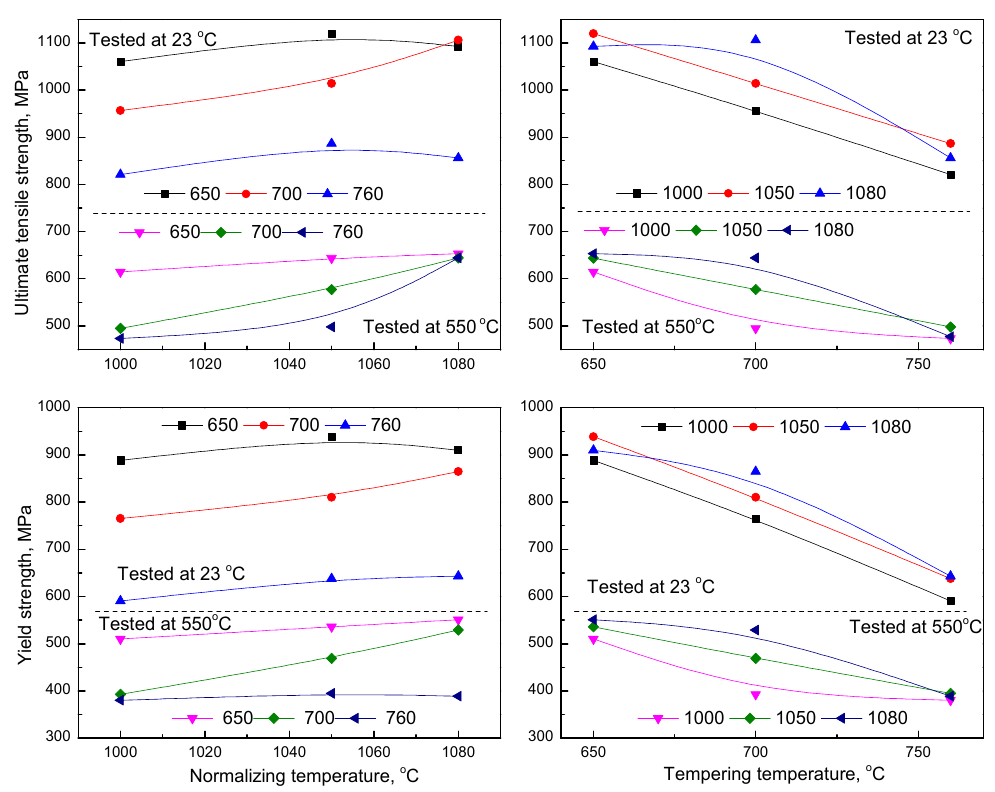
Figure 10. Tensile strength of 15Cr12MoVWN steel under different heat treatment conditions.